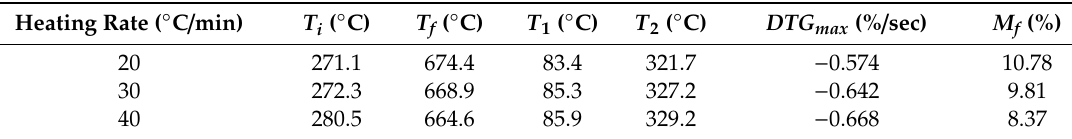
Table 3. Characteristic parameters of 15CVPS85ATS at di ff erent heating rates. Heating Rate ( ◦ C /